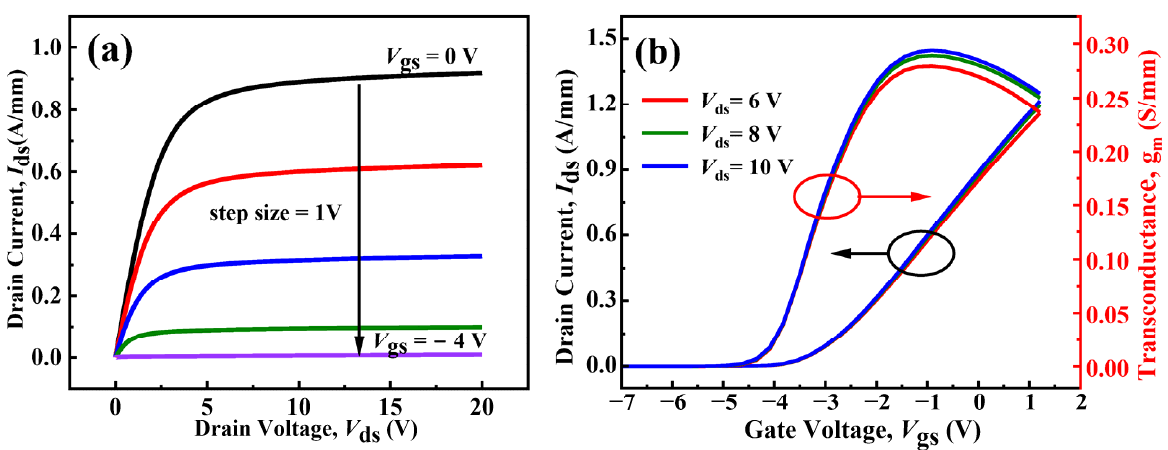
Figure 4. ( a ) DC characteristics of GaN HEMTs and ( b ) transfer and transconductance characteris ‐ tics of GaN HEMTs.